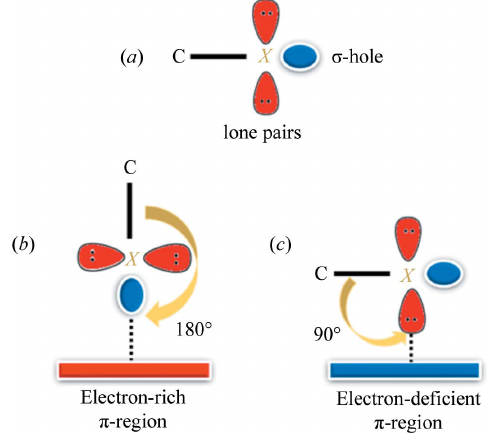
Figure 1 ( a ) A representation of a (cid:2) -hole on a halogen atom ( X = F, Cl, Br, I). ( b ) The ideal geometry for a (cid:2) -hole interaction. ( c ) The ideal geometry for a (cid:3) -hole interaction.